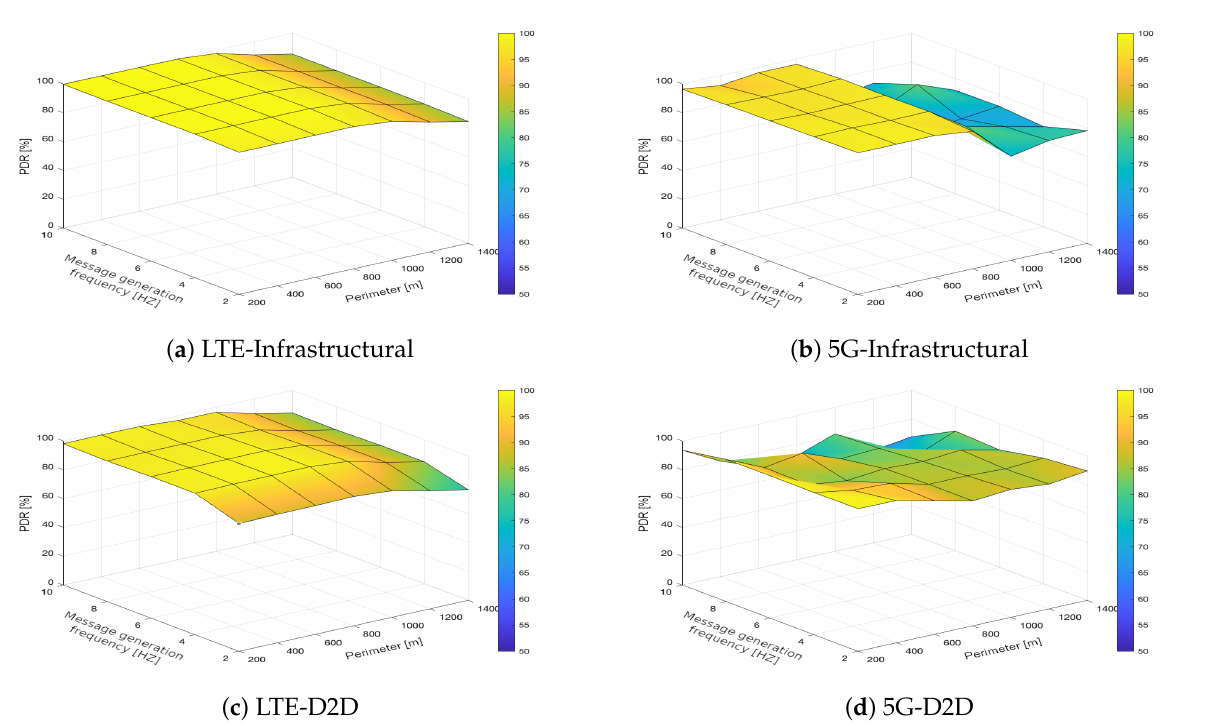
Figure 7. PDR simulated for all the investigated modes of the 4G-based and 5G-based C-V2X technologies and traffic intensity of 1500 vehicles per